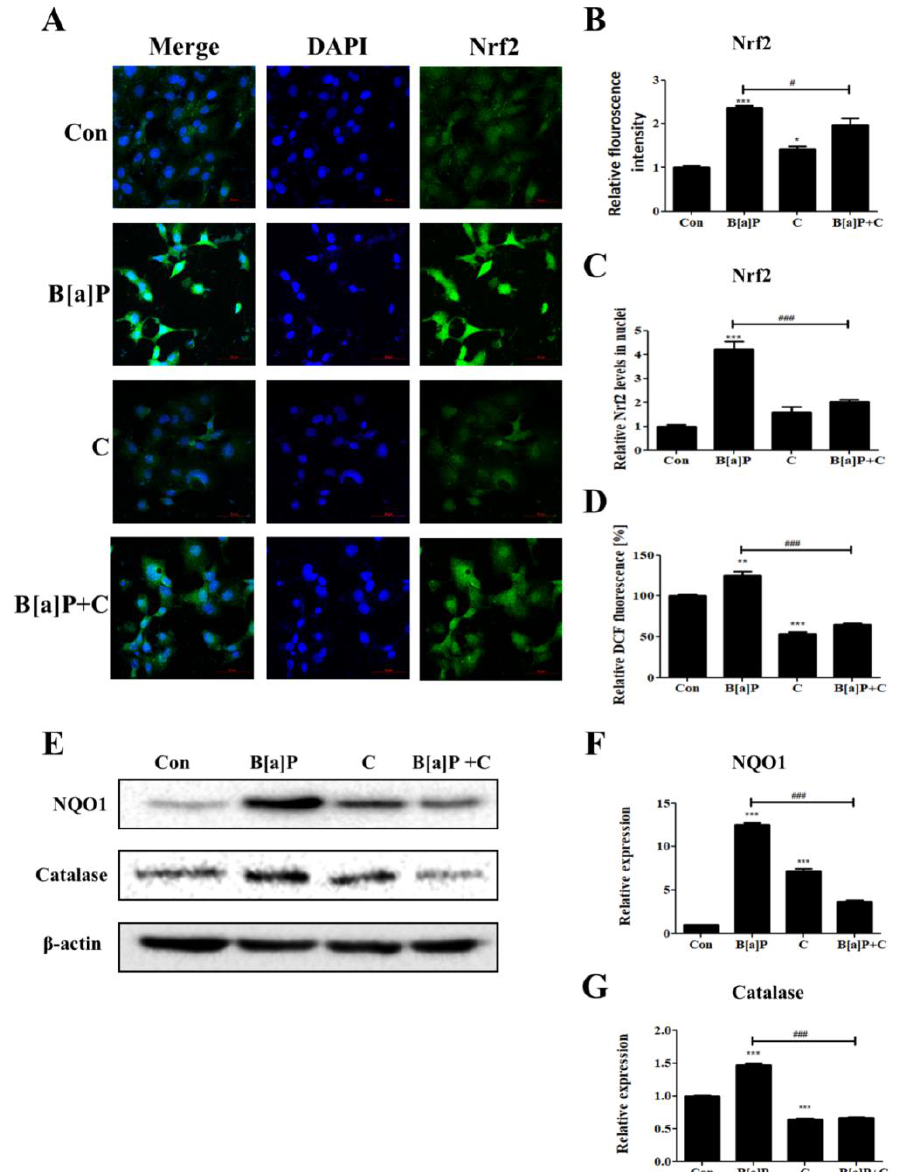
Figure 4. Inhibitory effect of curcumin on B[a]P-induced Nrf2 pathways ( A ) Cells were stained for Nrf2 (green). DAPI was used to stain the nuclei (blue). Objective: C-Apochromat 40×/1.2 W Korr FCS M27. Pinholes: 1.60 AU for DAPI and 1.58 AU for Nrf2. Optical section thickness: 1.5 µm for DAPI and Nrf2. Quantification of the effect of curcumin on the relative fluorescence intensities ( B ) and relative nuclear translocation of Nrf2 ( C ) induced by B[a]P treatment. N = 3 trials per sample and control. ( D ) Effect of curcumin on B[a]P-induced upregulation of cellular ROS. N = 5 trials per sample and control. ( E ) Effect of curcumin on the levels of phase-II antioxidant enzymes following the increased Nrf2 nuclear translocation. ( F ) Quantification of the levels of the phase-II antioxidant enzymes NQO1 ( F ) and catalase ( G ) in the cells cotreated with curcumin and B[a]P. N = 3 trials per sample and control. * p < 0.05, ** p < 0.01, and *** p < 0.001, compared with the control; and # p < 0.05 and ### p < 0.001, compared with the B[a]P-treated group. Con: control; B[a]P: benzo[a]pyrene (10 µM); C: curcumin (10 µM).